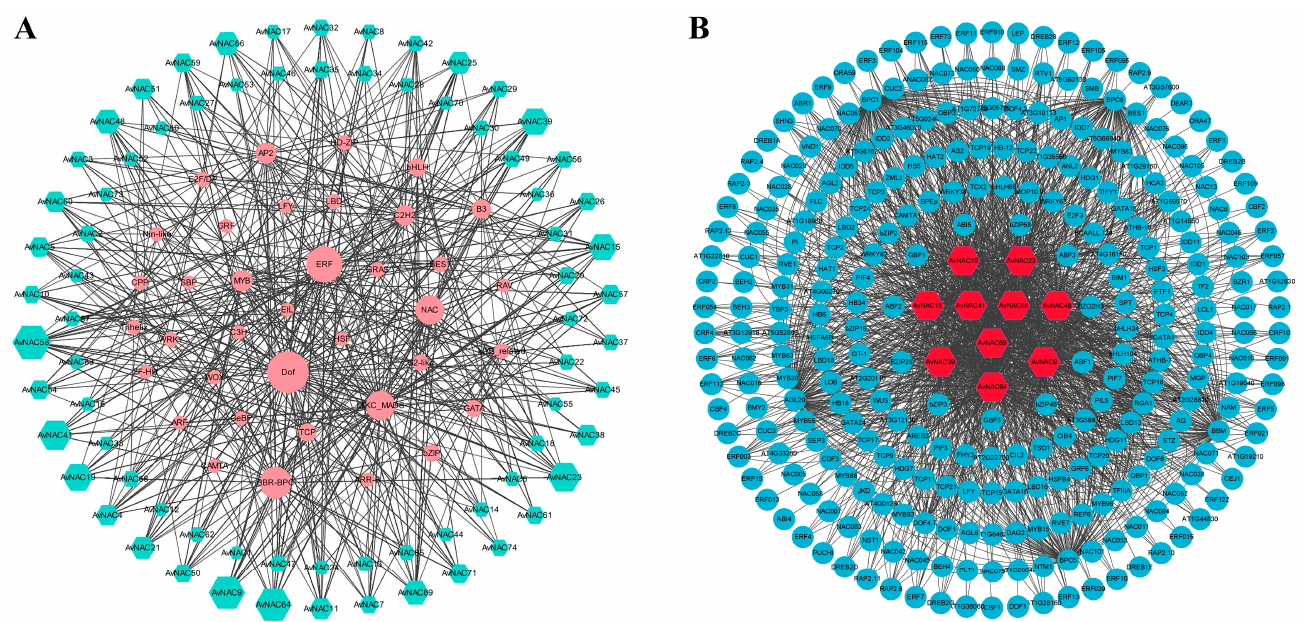
Figure 11. The putative transcription factor regulatory network analysis of AvNAC genes. ( A ) Inter- action network of NAC genes and putative transcription factors in A. venetum . The node size repre- sents the number of interactions. ( B ) The top 10 highly enriched and targeted AvNAC